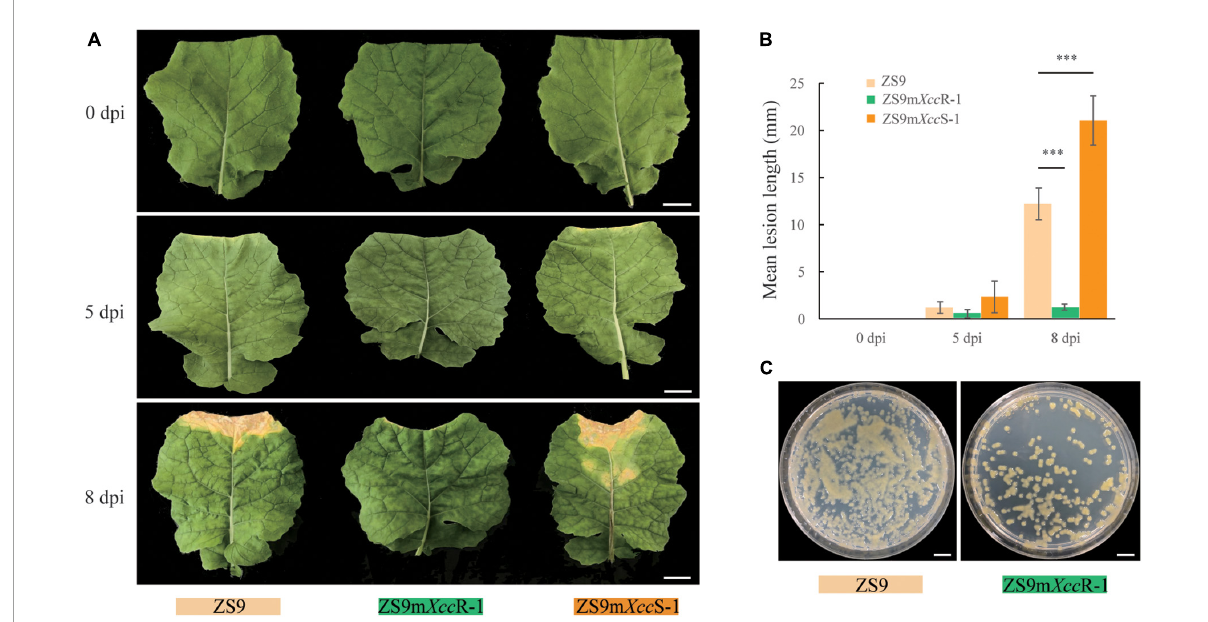
FIGURE1 Two B. napus EMS lines showing contrasting levels of Xcc resistance. (A) Disease symptoms observed on the parental line ZS9 and the two EMS lines ZS9m Xcc R-1 and ZS9m Xcc S-1. Pictures were taken at 0, 5, and 8 days after Xcc inoculation. (B) Lesion lengths on ZS9, ZS9m Xcc R-1, and ZS9m Xcc S-1 after inoculation with Xcc . Bars represent mean lesion lengths ± SD based on three biological repetitions. ∗∗∗ indicate significant differences ( p < 0.001) according to Student’s t -tests. (C) Extracts from ZS9m Xcc R-1 showing reduced bacterial titers compared to ZS9. Bars represent 20 mm in (A) and 10 mm in (C)